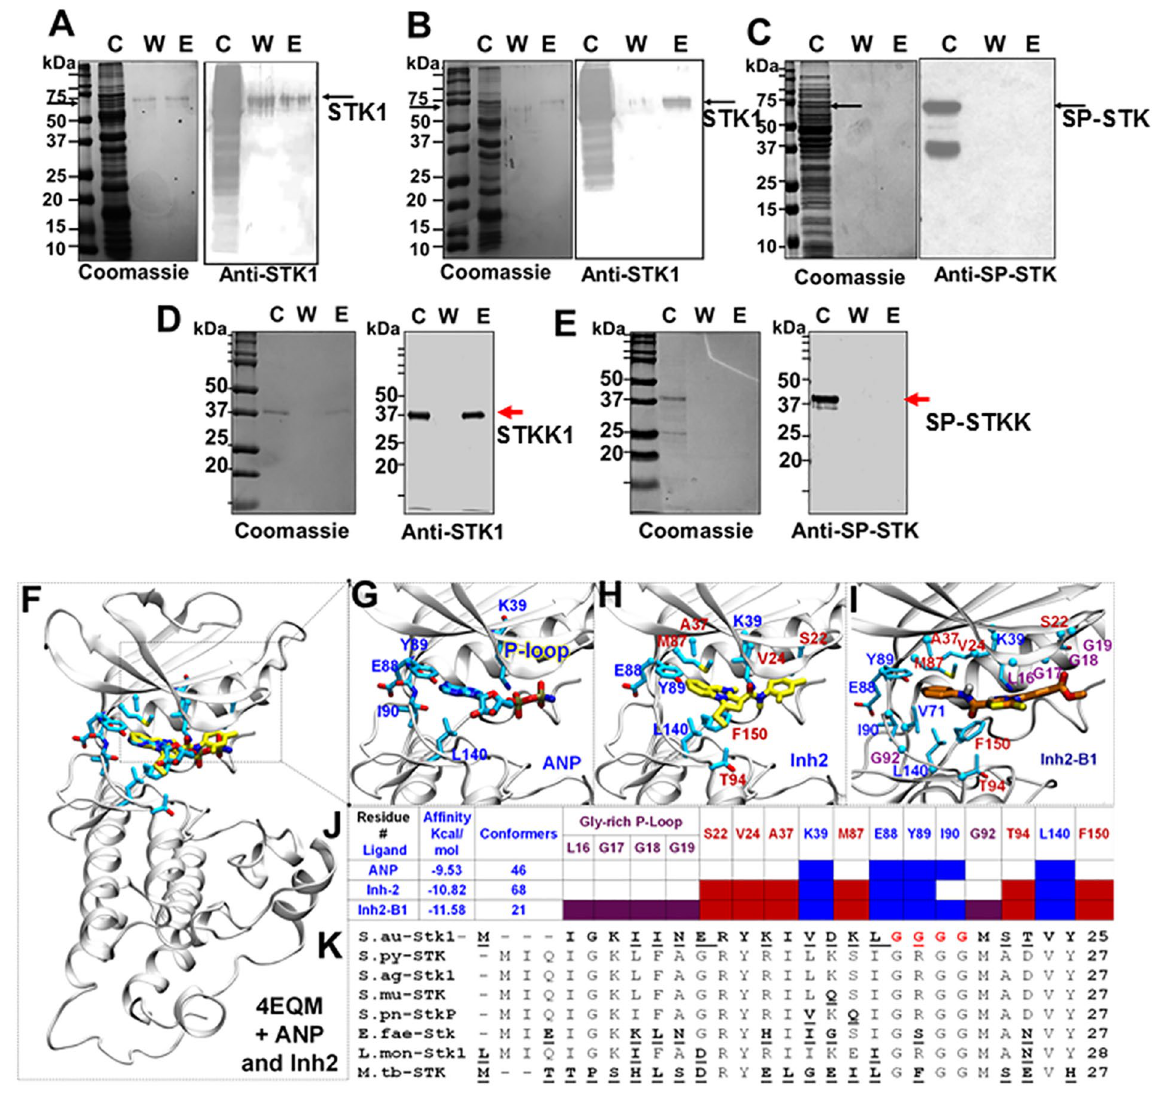
Figure 3. Binding of Inh2 and Inh2-B1 to the catalytic ATP-binding pocket of STK1. In vivo binding of ( A ) Inh2 and ( B ) Inh2-B1 to S . aureus STK1 as determined by ATP-column chromatography. Whole cell lysostaphin-digest of the MW2-wild type strain was passed on to the buffered equilibrated ATP-agarose column and eluted with 50 µ M Inh2 or Inh2-B1 followed by detection of STK1 in Western Blot assay using the anti- STK1 polyclonal antibody as described in the Materials and Methods section. ( C ) A similar experiment with whole cell lysate of the phage-lysin digested S . pyogenes M1T1 strain revealing no elution of SP-STK. STK1 (~90 kDa) and SP-STK (~70 kDa) proteins (see pointed arrow) in their respective bacterial lysates are found without/ with its degraded forms as described previously 20, 36 . C-cell lysate, W-wash fraction, E- elution fraction. ( D ) Binding of the purified recombinant STKK1 to solid-phase ATP- column and its elution by Inh2-B1. ( E ) Binding of the purified recombinant SP-STK to solid-phase ATP- column and its elution by Inh2-B1. ( F ) In silico , molecular docking analysis-based the highest scored docked pose of ANP and Inh2 in the binding pocket of the kinase domain of S . aureus STK1 (PDB ID 4EQM). The protein is shown in the white cartoon. Interaction of ( G ) ANP (inactivated ATP shown in cyan), ( H ) small molecule compound Inh2 (shown in yellow) and ( I ) Inh2-B1 (shown in dark orange) and key residues (only the side-chain non-hydrogenous atoms) around 3.5 Å from the inhibitor are shown in the sticks. The coloring code of the atom type: C (Yellow or green in inhibitors and cyan in ANP), N (blue), and O (red). ( J ) A summary table is showing the association of ANP, Inh2, and Inh2-B1 with amino acid residues reflecting their affinity for the ATP-binding pocket and a number of conformers clustered in this region during molecular docking analysis. ANP constitutes key residues (blue fonts). The residues around Inh-2 are shown in red fonts and the residues around P-loop that directly interact with Inh2-B1 are shown in purple fonts (See also Fig. S5 for affinity and number of conformers for all Inh2 derivatives). ( K ) A comparison of the N-terminal sequence of STK1 with those of other Gram-positive pathogens showing the unique nature of the S . aureus STK1 P-loop (Red fonts). The underlined bold letters denote non-conserved amino acid